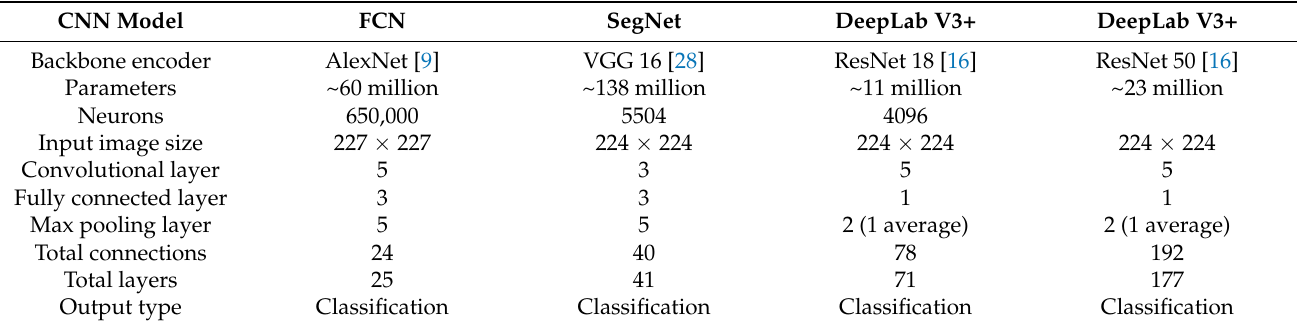
Table 1. Summary of the pretrained CNN models used.